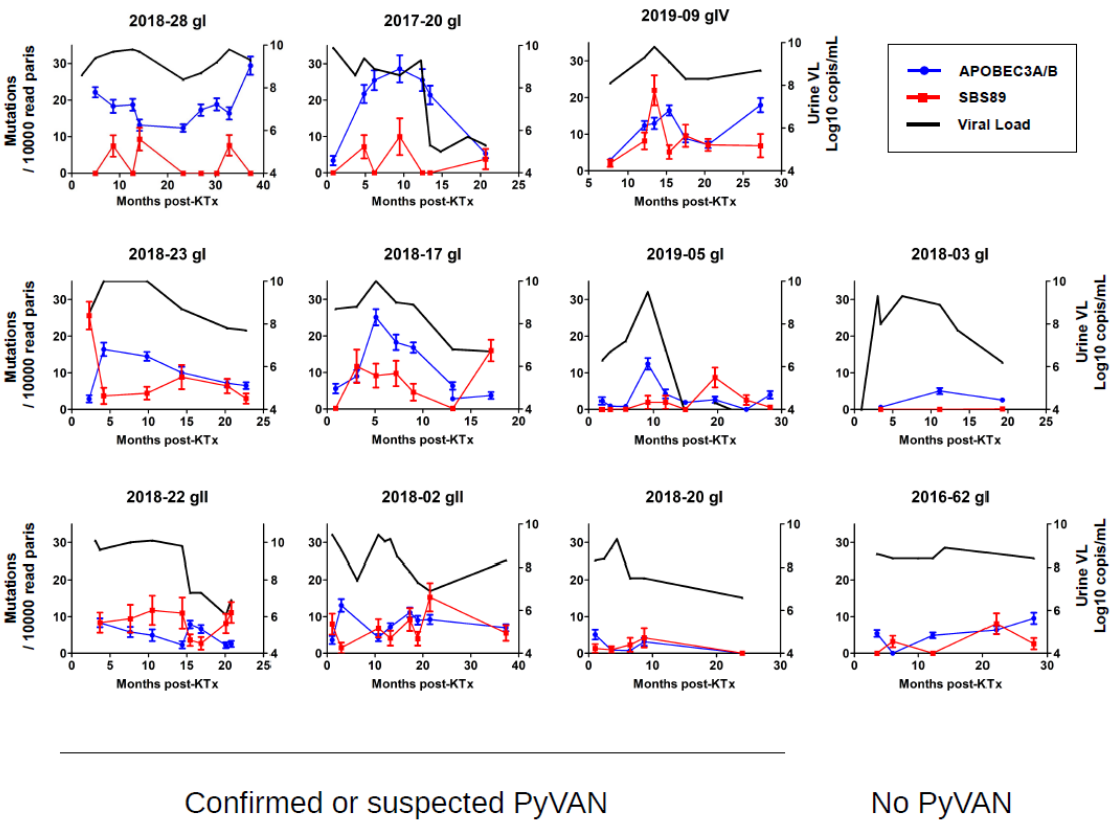
Figure 4. Intrapatient variation in APOBEC3A/B and SBS89 mutation rates over time. Viral load (Log10 copies/mL, right axis, Black line), APOBEC3A/B (blue), and SBS89 (red) mutation rates (mutations per 10,000 read pairs, left axis) in sequential urine samples are plotted against time post KTx. Error bars show the 95% confidence interval of the mean APOBEC3A/B and SBS89 mutation rates in the sample calculated from 50 SBS fitting iter- ations.